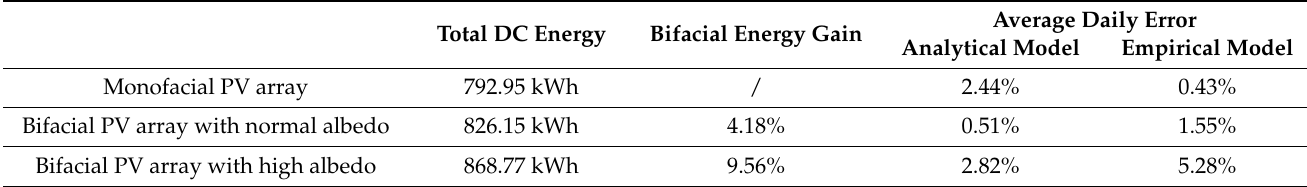
Table 3. Difference between the produced and the simulated energy over 166